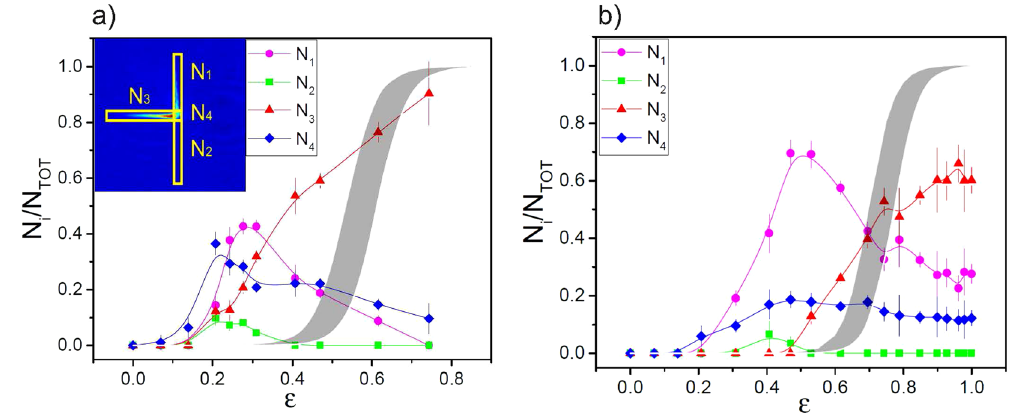
Figure 8. Relative population of the different classes of non-transmitted atoms (inset) as a function of the lattice height, revealing the complexity and different mechanisms governing the atom dynamics in the splitter. Measurements are shown for two different regimes: ( a ) v = 2.7v R and ( b ) v = 3.7v R . Solid grey areas show the maximum quantum reflection probability by a single barrier calculated using the analytical expression in ref. 17. Solid lines are guides to the eyes. Please refer to the insets of Fig. 3 for the definition of the waveguides’